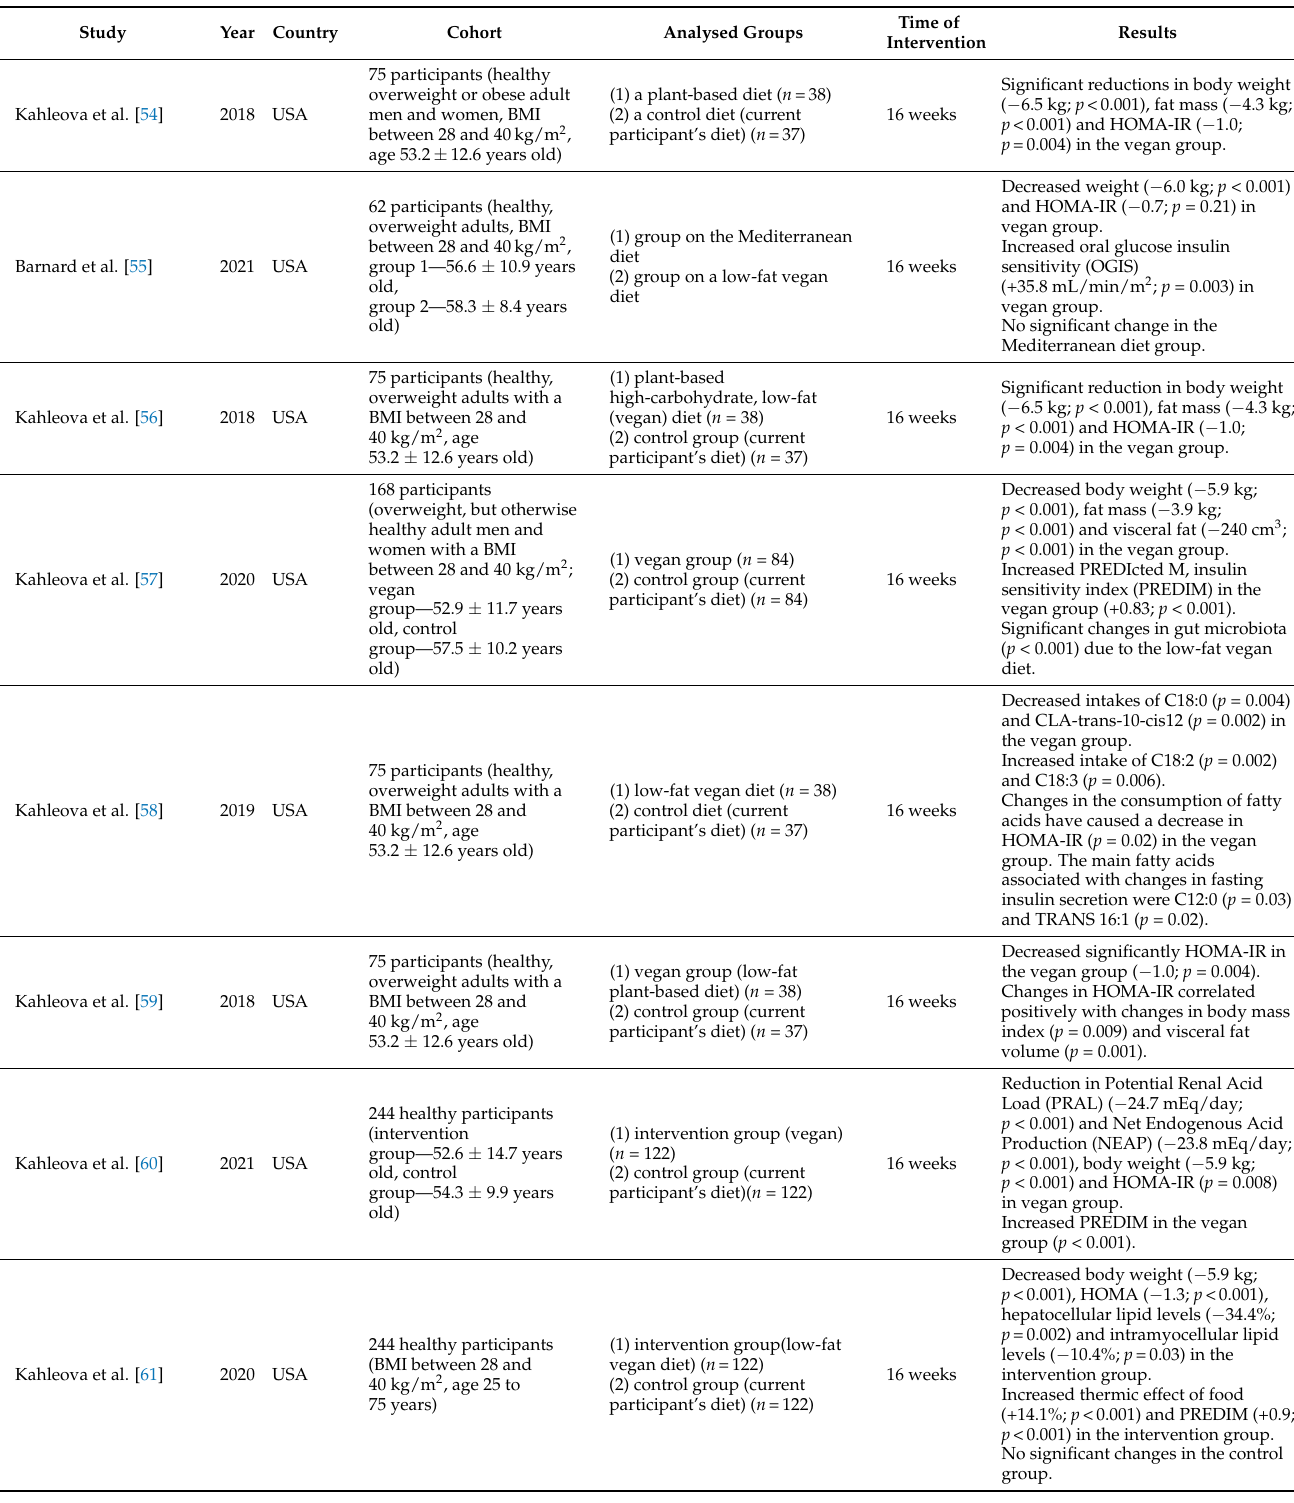
Table 3. The influence of a vegan diet on insulin